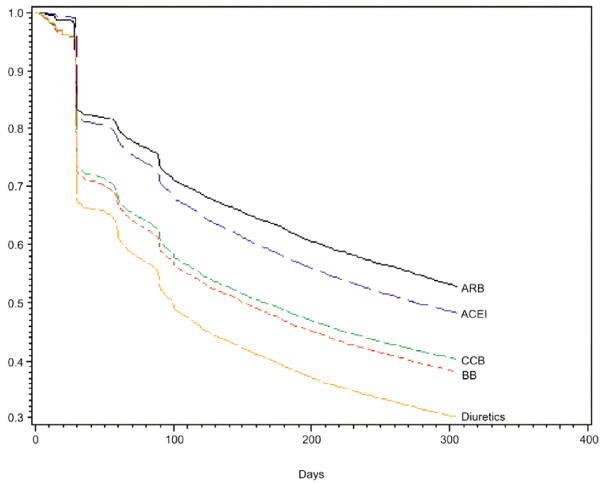
Time to therapy discontinuation of antihypertensive monotherapy [16]. This depicts the proportion of study patients by antihypertensive medication class who remained persistent with index therapy (y axis) during the year subsequent to the index study claim (days subsequent to index date depicted on x axis). ARB patients were most likely to remain on therapy, closely followed by ACEi patients. Diuretic patients were least likely to remain on the index monotherapy regimen.